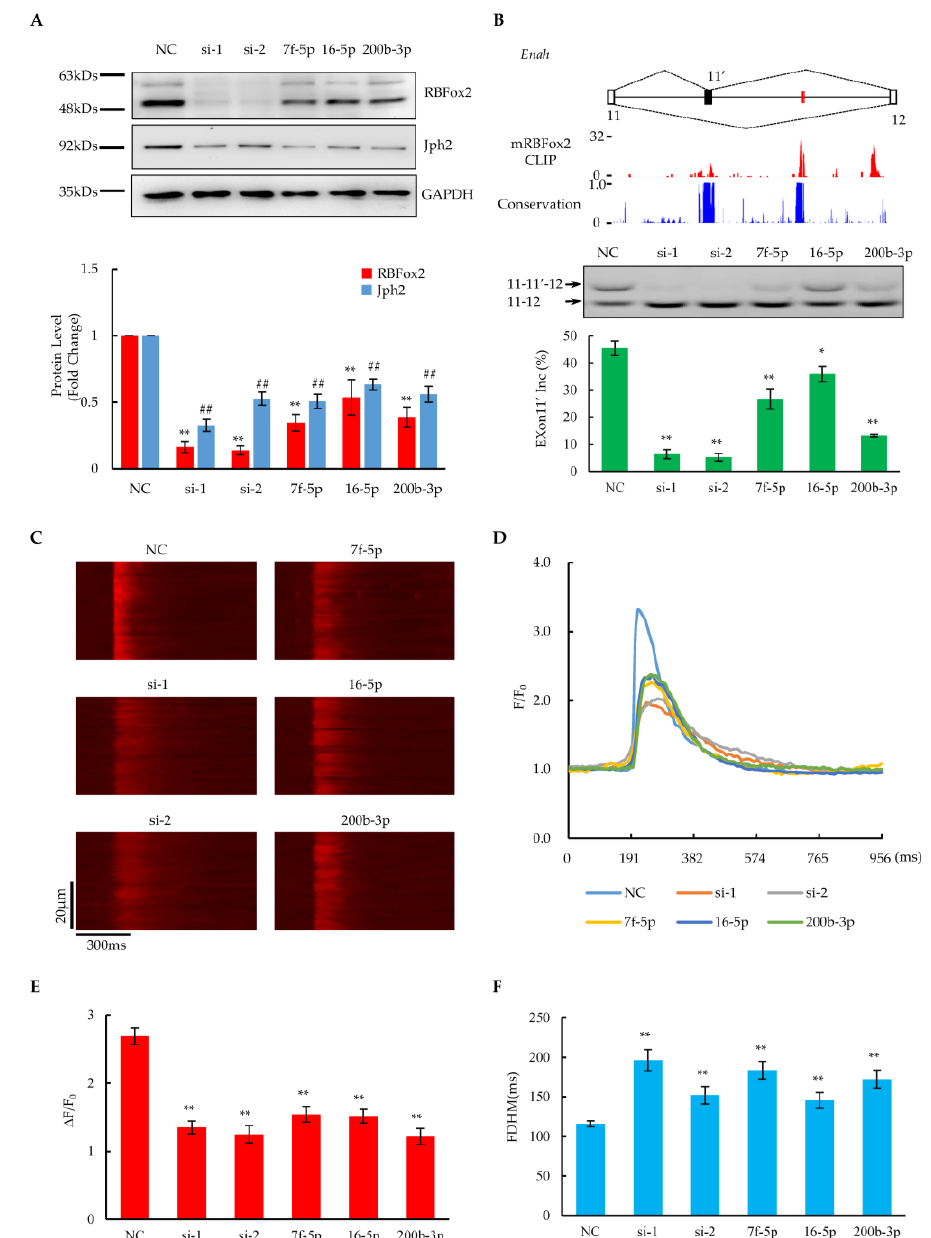
Figure 4. Effect of miRNAs on RBFox2 protein and its related biological functions. ( A ) Upper panel shows Western blotting analysis of RBFox2 and Jph2 protein levels after transfection with RBFox2-targeted miRNA or RBFox2 siRNA in NRCMs, respectively. Bottom panel shows relative fold changes in RBFox2 and Jph2 protein levels normalized to GAPDH. Values are shown as means ± SEM. NC: negative control; Si: RBFox2 siRNA; 7f-5p: Let-7f-5p; 16-5p: miR-16-5p; 200b-3p: miR-200b-3p. n = 3 for each group; ** p < 0.01 for RBFox2; ## p < 0.01 for Jph2. ( B ) Splicing changes in alternative exon 11 of Enah. Top: The gene structure illustrating the alternative exon. The red lines indicate the locations of conserved (U)GCAUG motifs. Middle: The bar charts of RBFox2 CLIP-seq signals from mouse cardiomyocytes and conservation scores across species. Bottom: The PCR re- sults and analysis percentages of exon 11′ inclusion in each sample. Values are shown as means ± SEM. n = 4 for each group; * p < 0.05, ** p < 0.01. ( C ) Confocal images of spontaneous calcium transi- ents in NRCMs after transfection with miRNAs or siRNAs. ( D ) Spatially averaged traces of calcium transient, corresponding to ( C ). ( E , F ) Statistics of amplitude ( F/F0) and full duration at half-maxi- mum (FDHM) of calcium transients. The data are expressed as means ± SEM. n = 43 for NC, n = 21 for si-1, n = 20 for si-2, n = 17 for 7f-5p, n = 28 for 16-5p, and n = 22 for 200b-3p; ** p < 0.01.